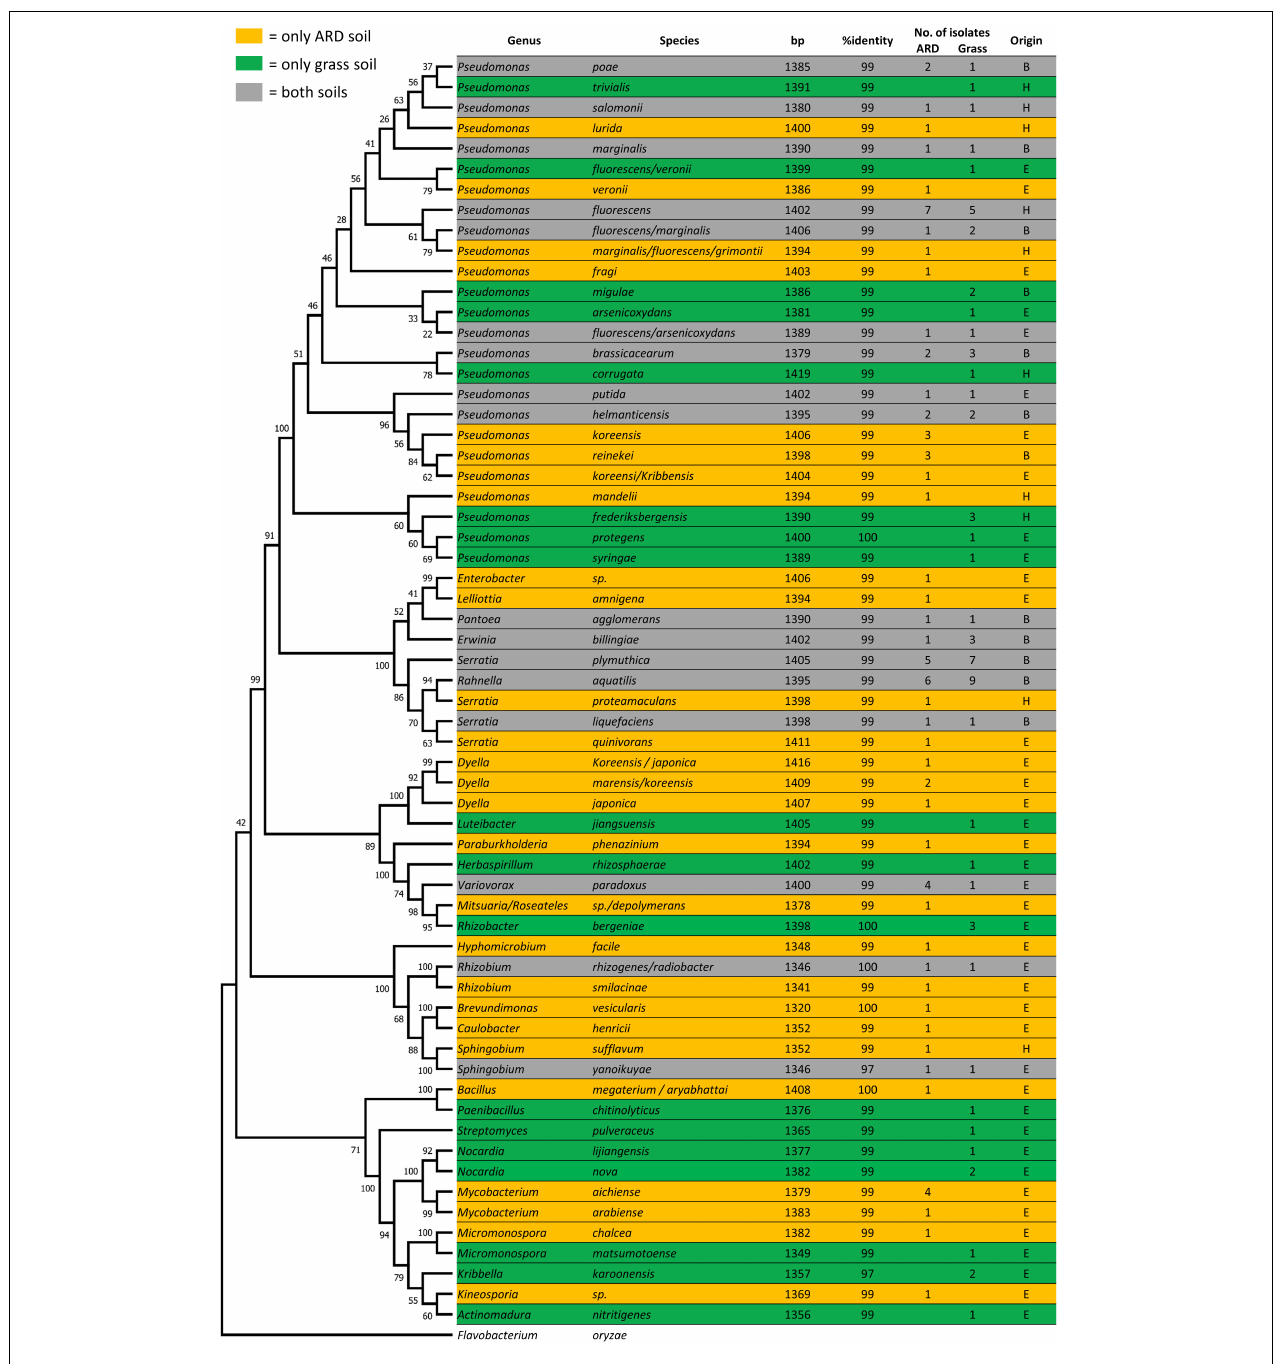
FIGURE 4 | Phylogenetic tree based on 16S rRNA gene sequences of all different endophytic isolates using the Maximum Likelihood method and Tamura–Nei model. The percentage of replicate trees in which the associated taxa clustered together in the bootstrap test [1,000 replicates (Felsenstein, 1985)] are shown next to the branches. The closest hit with species level and corresponding identity using the NCBI database is shown. Only isolates with more than 1,300 bp were selected for alignment. Flavobacterium oryzae was used as an outgroup to root the tree. Isolates were obtained from roots grown only in ARD plots (yellow), grass plots (green), or both plots (gray) from the sites Heidgraben (H), Ellerhoop (E), or both (B) sites.